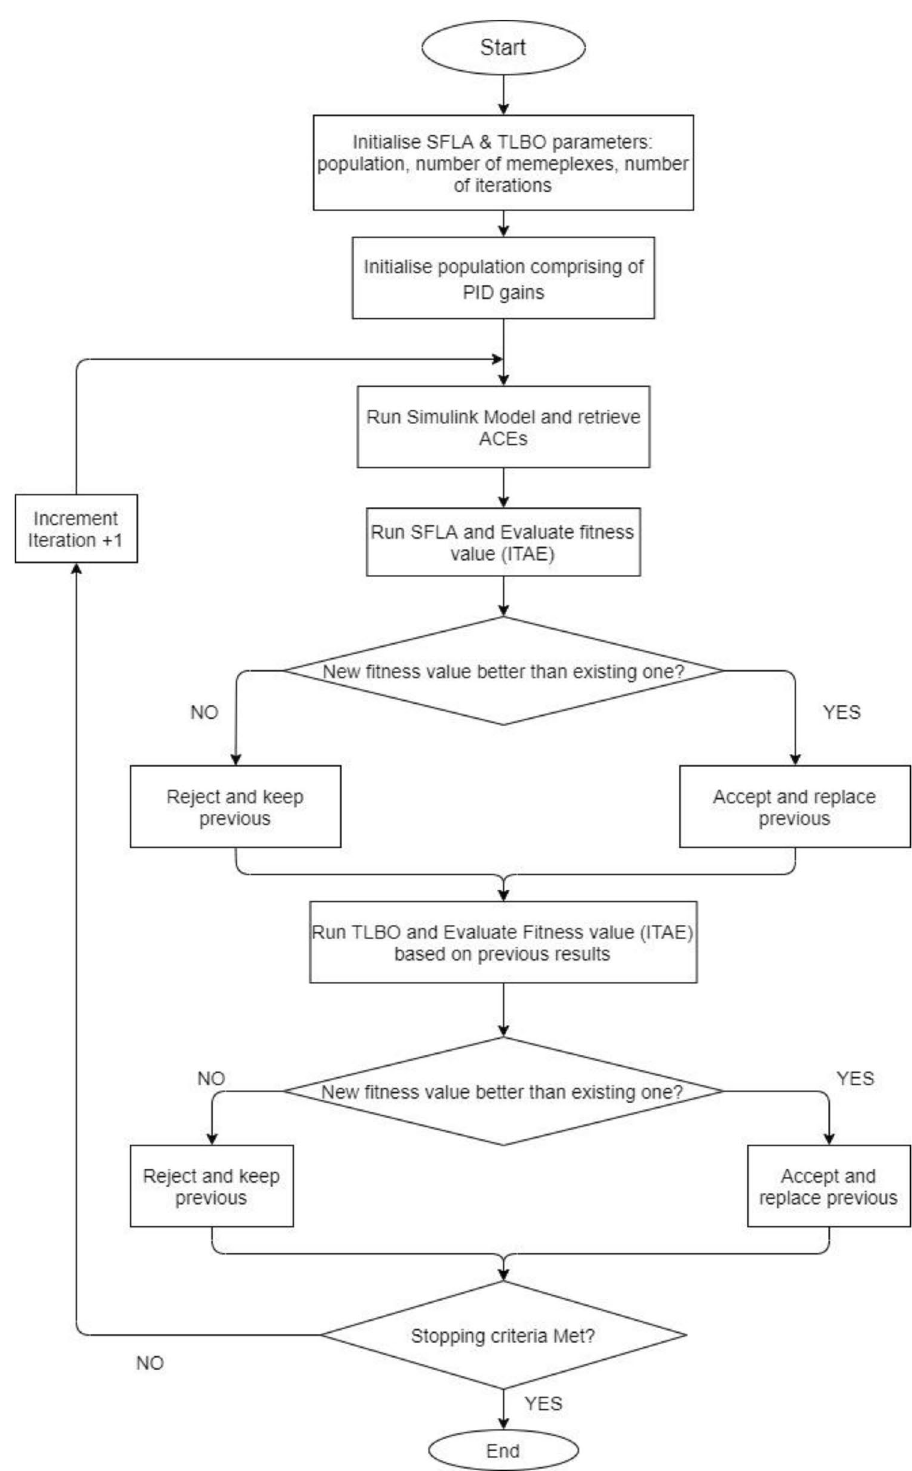
Fig. 4 Hybrid SFLA-TLBO